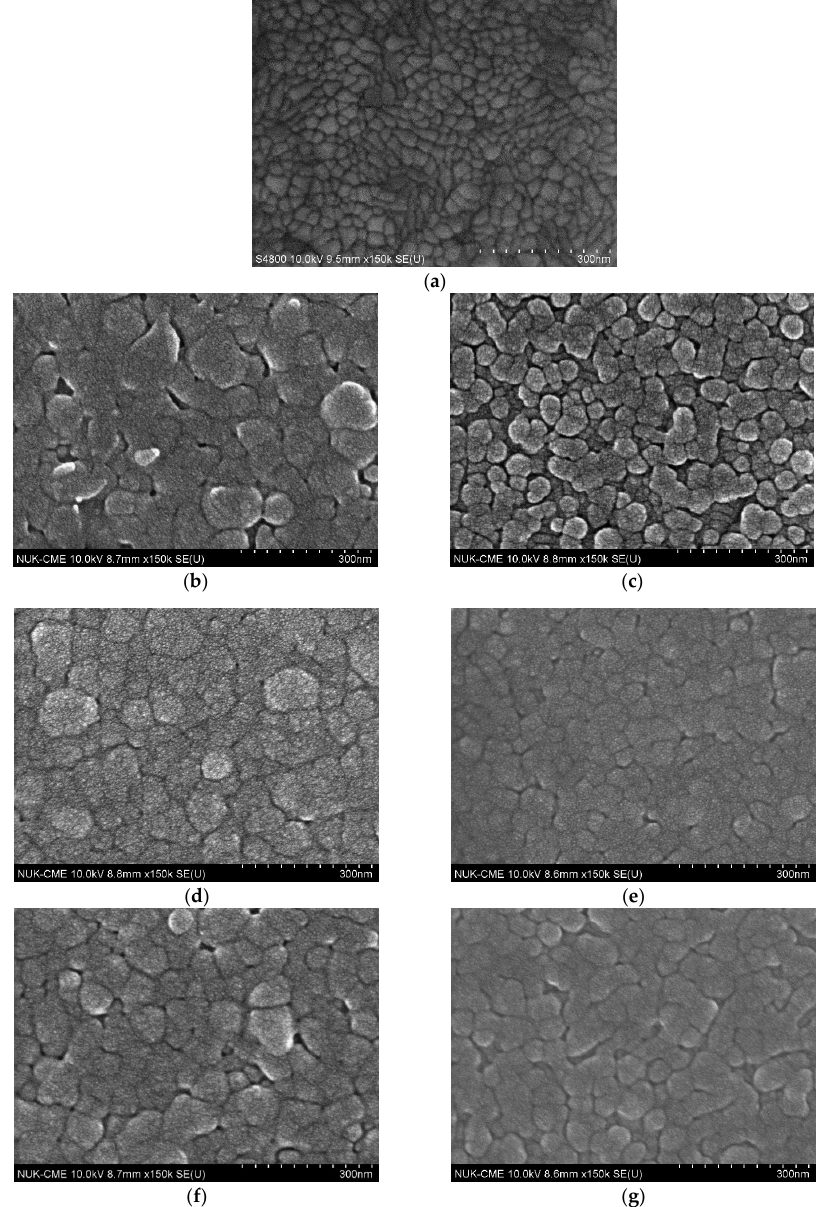
Figure 2. Scanning electronic microscopy images. ( a ) bare ITO glass; ( b – g ) testosterone-imprinted ( left ) and non-imprinted ( right ) poly(aniline-co-metanilic acid) containing 50 mole % of aniline: ( b , c ) before washing; ( d , e ) after washing; ( f , g ) after washing (template removed). The washed, imprinted films show considerable surface roughness, presumably owing to the presence of numerous binding sites or cavities.